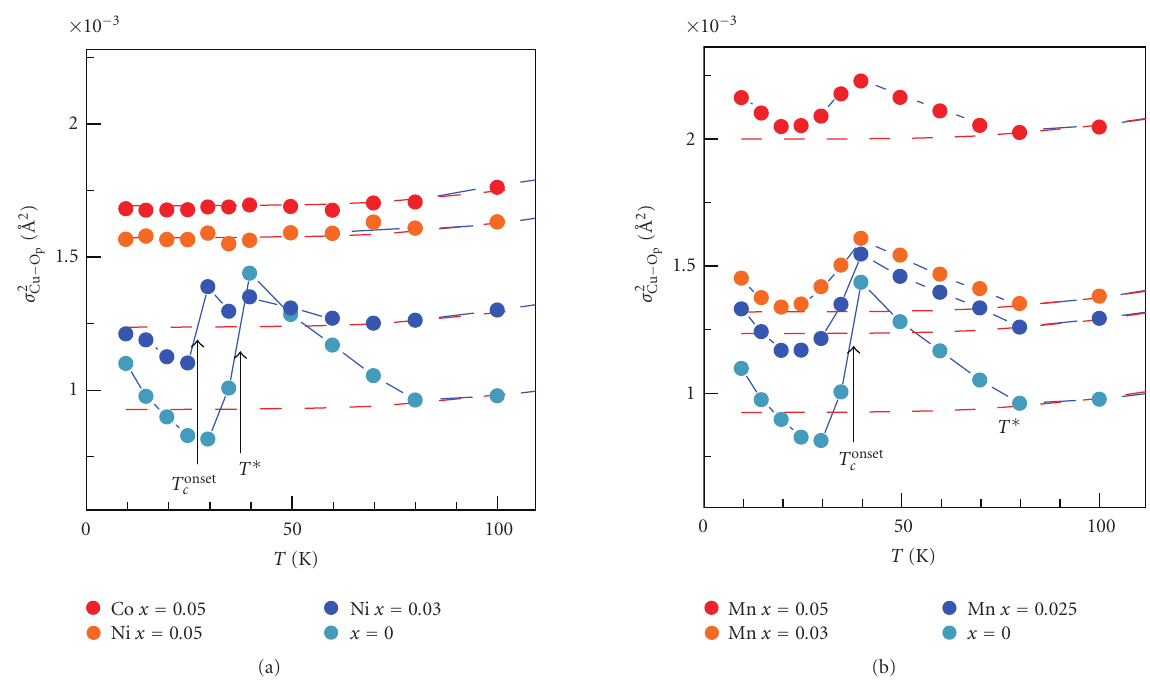
Figure 8: Mean-square relative displacement of the i n-plane Cu–O bond in magnetic impurity doped M: La 1 − x Sr x CuO 4 ( x = 0 . 15) as a function of temperature. (a) M = Co, Ni an (b) M = Mn, taken from [11].